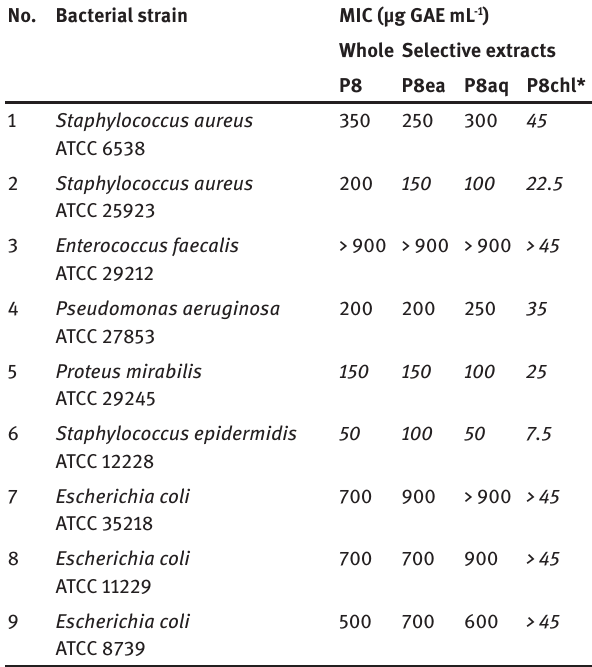
Table 2 : MIC values of Epilobi hirsuti herba extracts tested on ATCC bacterial